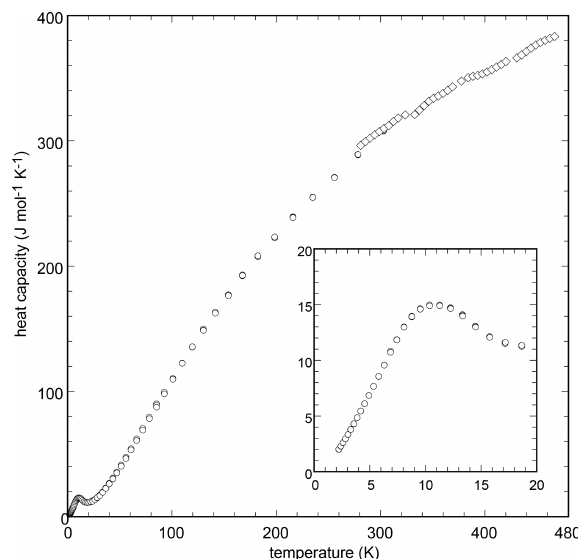
Figure 4. Low-temperature (circles) and high-temperature (dia- monds) heat capacity of chapmanite, measured by the PPMS and DSC instruments, respectively. The inset shows the C p anomaly at very low